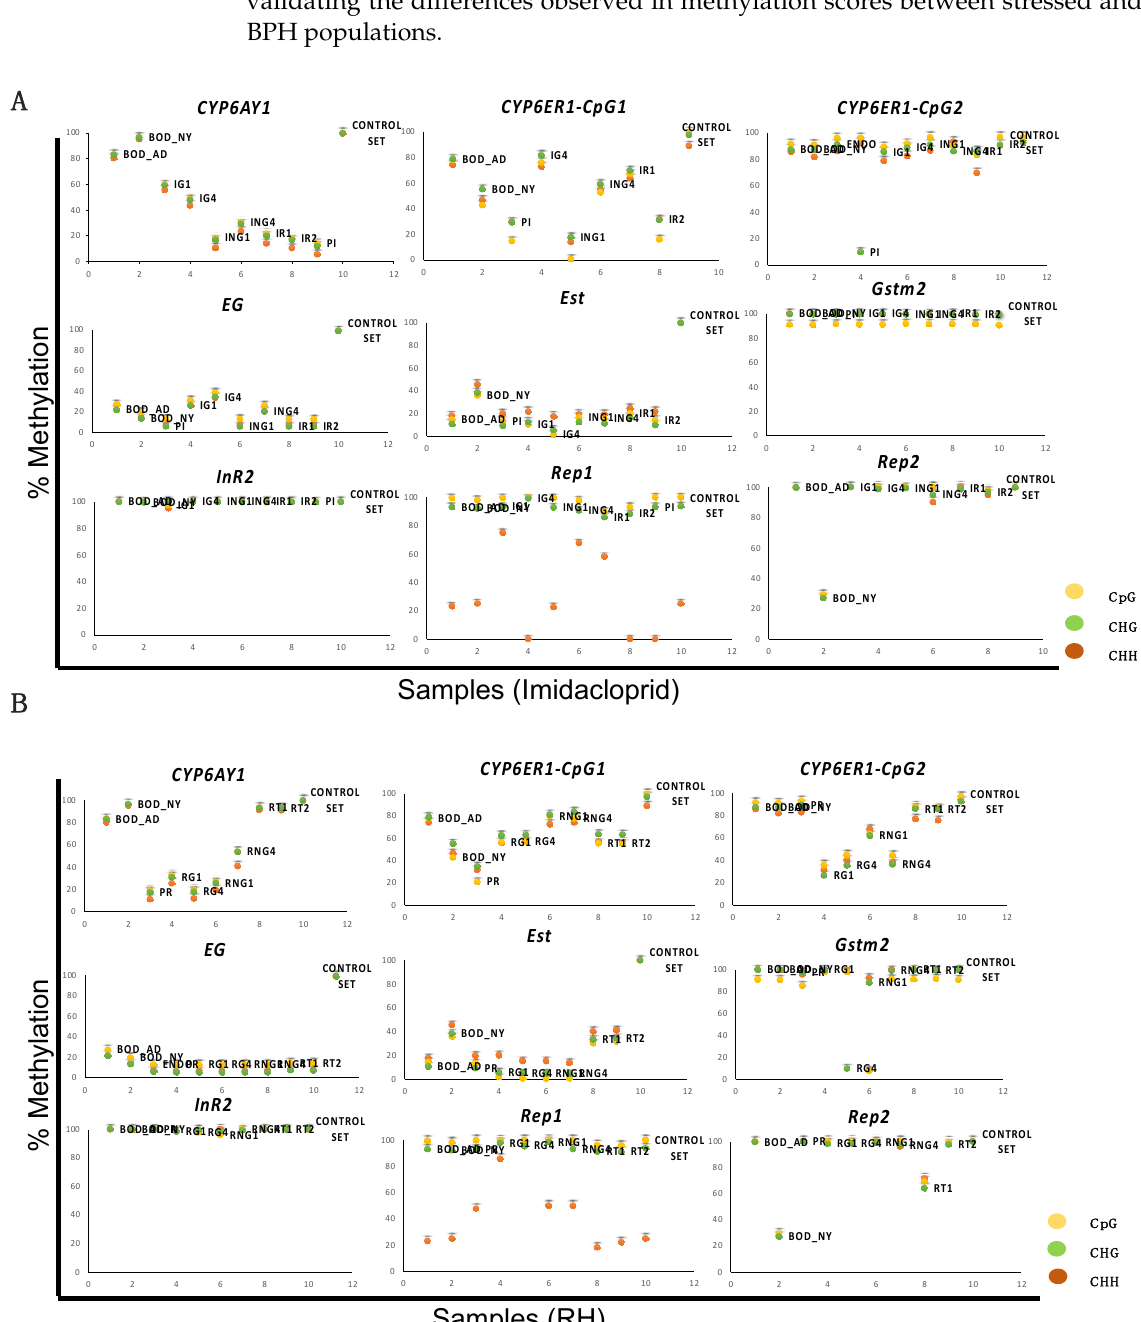
Figure 4. Fluctuations in methylation values of BPH genes (in CG, CHG, and CHH contexts) under stress and after its withdrawal (reversal populations). ( A ) upon exposure to pesticide (imidacloprid). ( B ) under nutritional stress (RH).